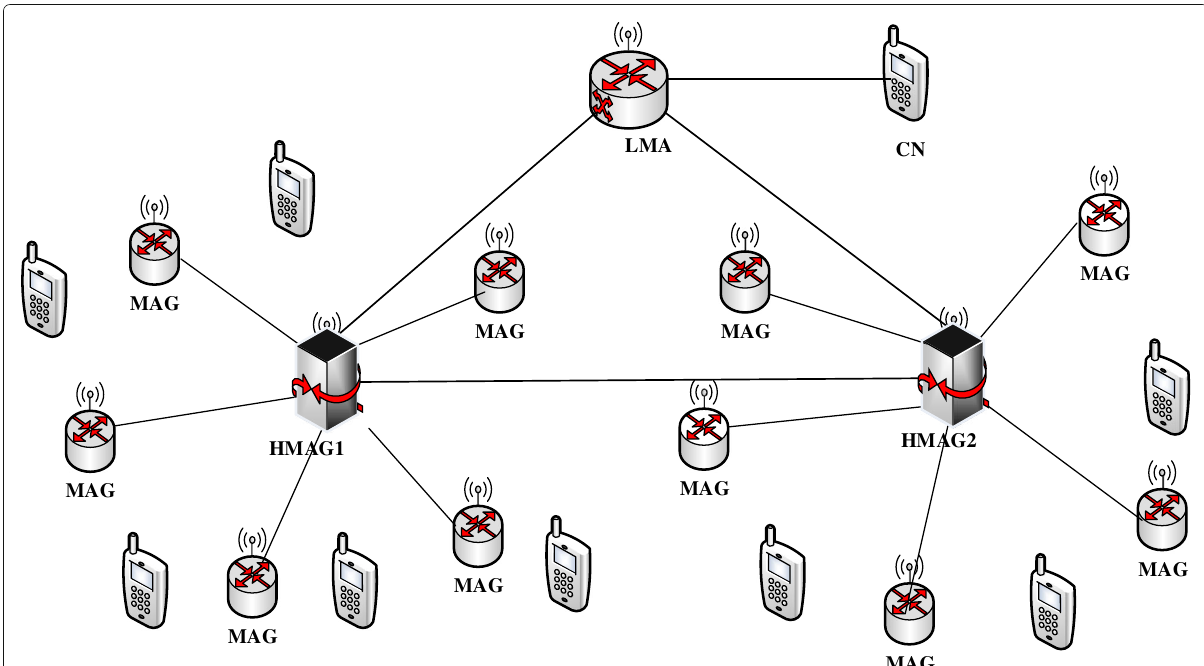
Fig. 11 The network topology used for